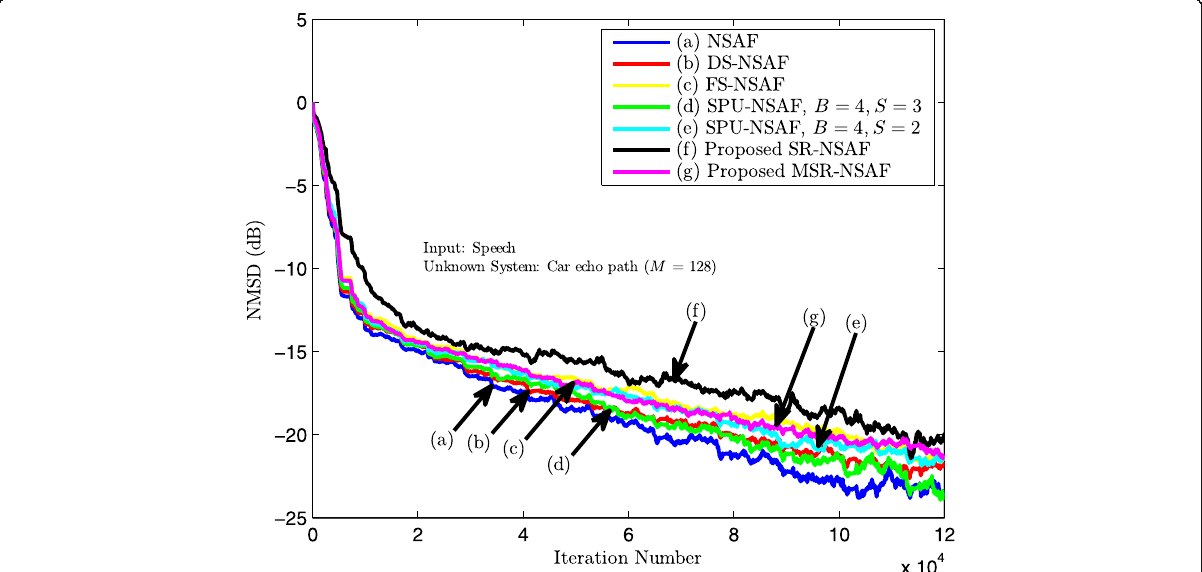
Fig. 10 NMSD learning curves of NSAF, DS-NSAF, FS-NSAF, SPU-NSAF, SR-NSAF, and MSR-NSAF with N = 4. Exact-modeling scenario, speech input